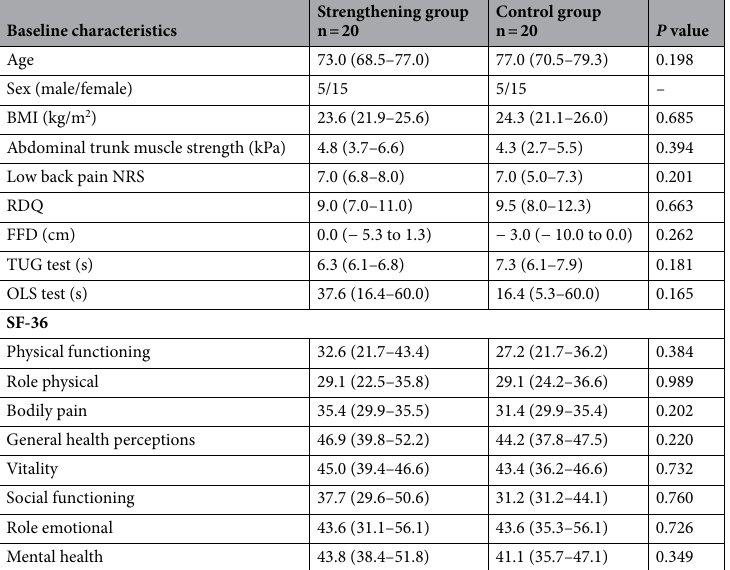
Secondary outcomes. Table 2 summarizes the outcome measures in each group at baseline and 12 weeks. Significant improvement in FFD and TUG at 12 weeks was observed compared to the baseline values in both groups. OLS at 12 weeks was significantly longer than that at baseline in the strengthening group. All subscales